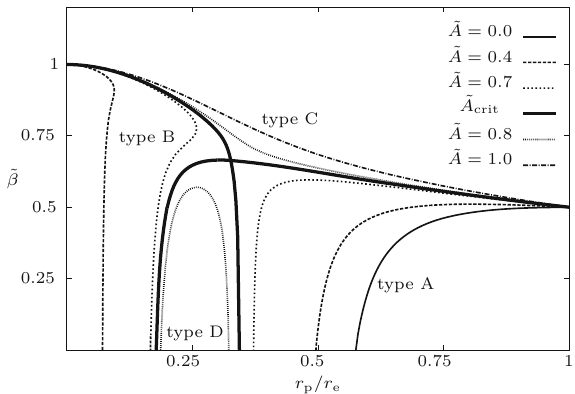
Fig. 9 Different types of sequences of differentially rotating equilibrium models (see text for a detailed description). Here ˜ A = ˆ A − 1 . (Image reproduced with permission from Ansorg et al. 2009, copyright by the